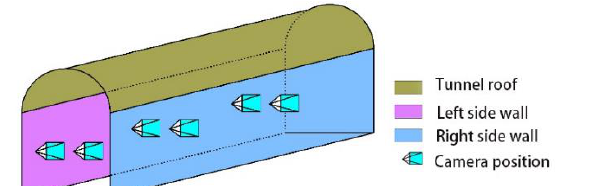
Figure 3. Schematic diagram of the tunnel double-line parallel sequence image.